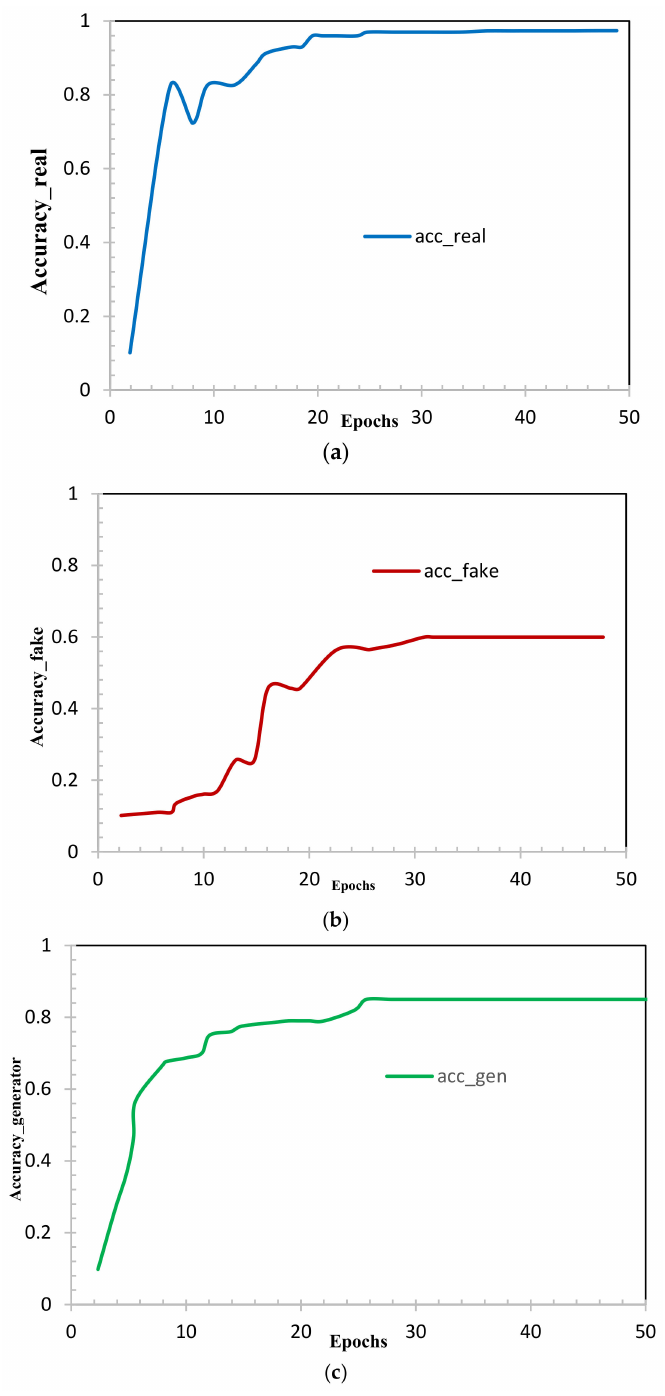
Figure 8. Accuracy of ( a ) real samples, ( b ) fake samples and ( c )